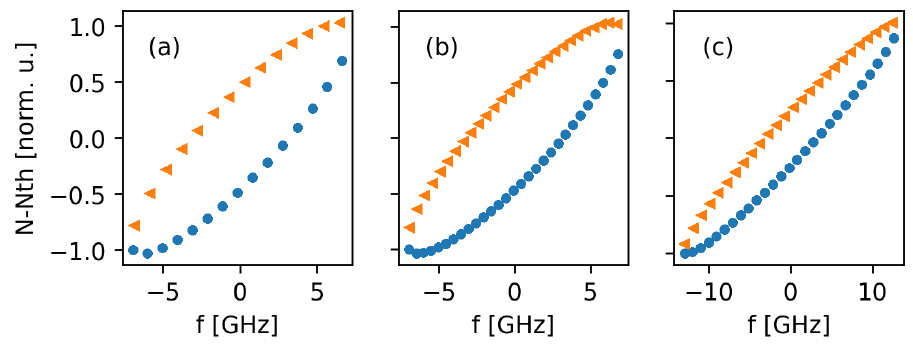
Figure 6. Ellipse of steady-state solutions for the Lang–Kobayashi model. External cavity modes are depicted as blue circles and antimodes as orange triangles. ( a ) Parameters: κ = 20 ns − 1 , τ = 1 ns, and α = 2. ( b ) Parameters: κ = 20 ns − 1 , τ = 2 ns, and α = 2. ( c ) Parameters: κ = 20 ns − 1 , τ = 1 ns, and α =